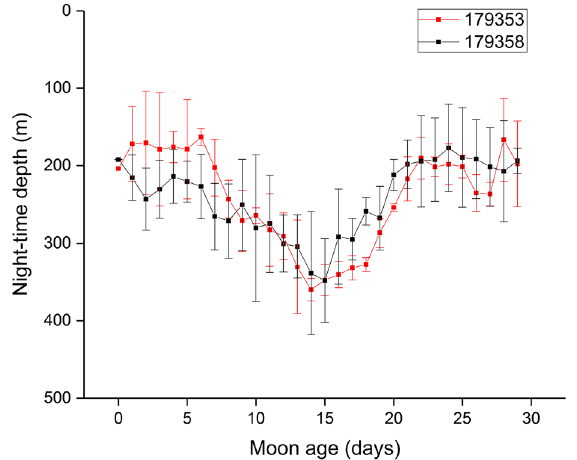
Figure 4. Night-time depth of the two longest tracks as a function of the age of the moon (new moon is at moon age 0, full moon is at age 14–15 days). The depth is measured over the period 12:00–15:00 UTC for a given day of the moon cycle and is averaged over 2–4 cycles for each